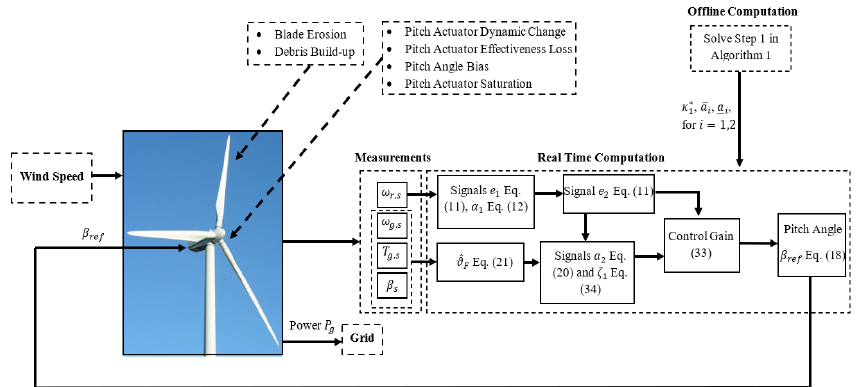
Figure 2. Block diagram of the design procedure.